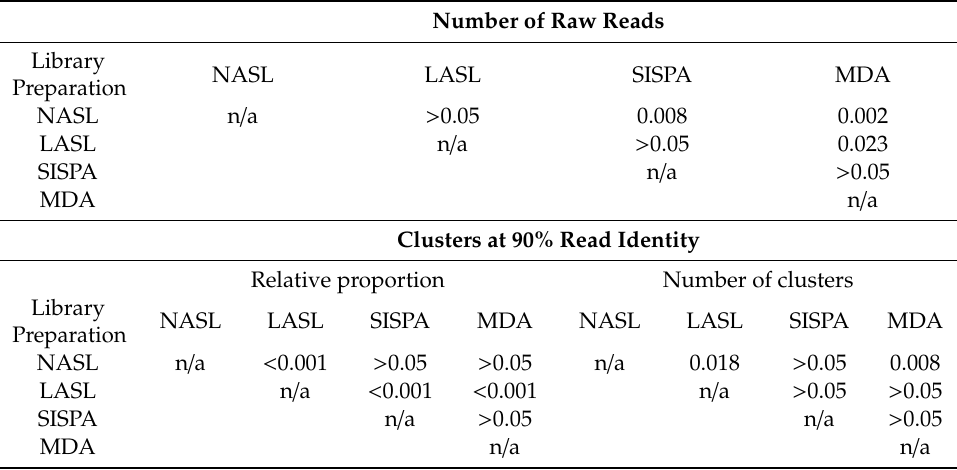
Table 1. P -values of analysis of variance (ANOVA) of raw sequencing read and read cluster numbers between the di ff erent library preparation